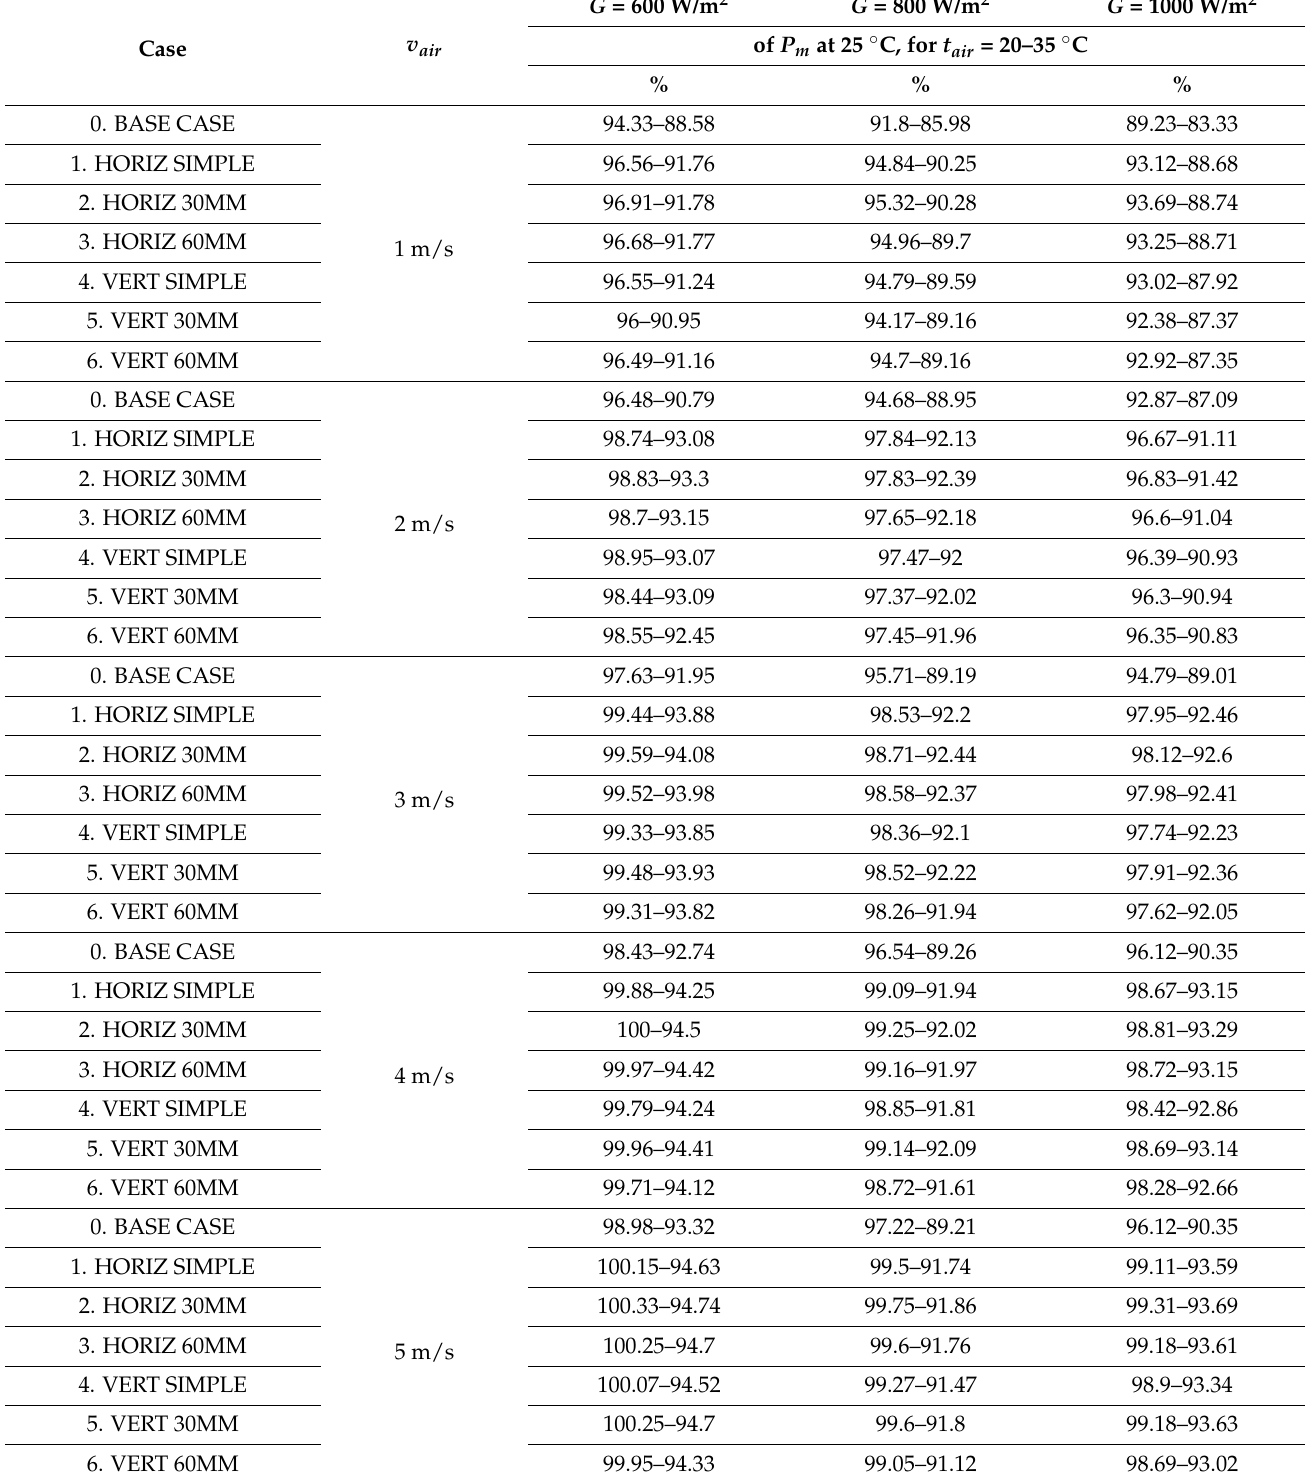
Table 7. Percentage of maximum power production achieved by the PV panel for each studied